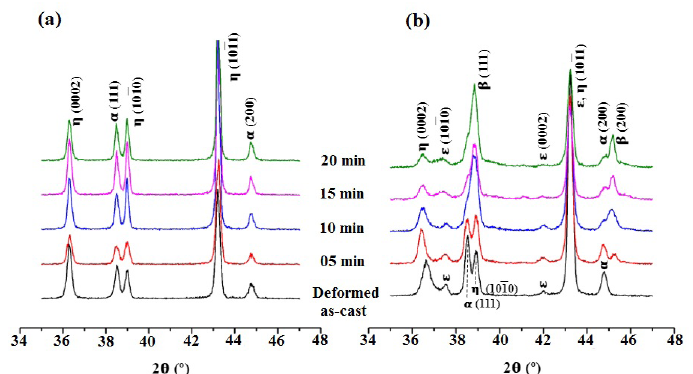
Figure 6. X-ray diffractograms of the deformed sample of the alloys during partial remelting at semi-solid temperature of 460 °C: (a) ZA27 and (b)